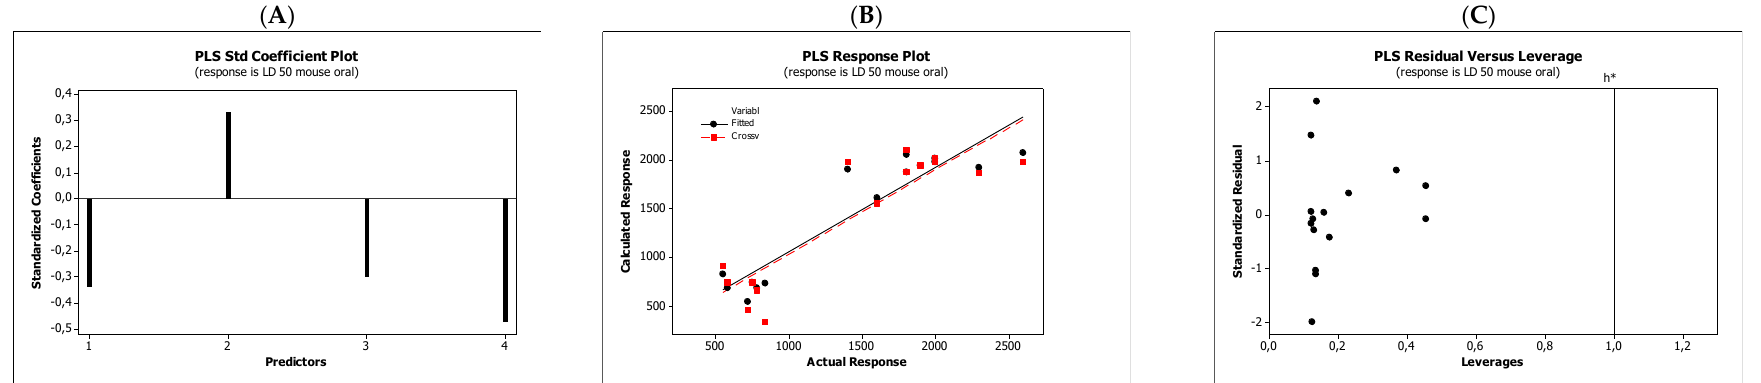
Figure 13. Standardized coefficients ( A ), the correlation between actual and predicted LD 50 mouse oral parameters ( B ), and the Williams plots ( C ) of Equation (12).